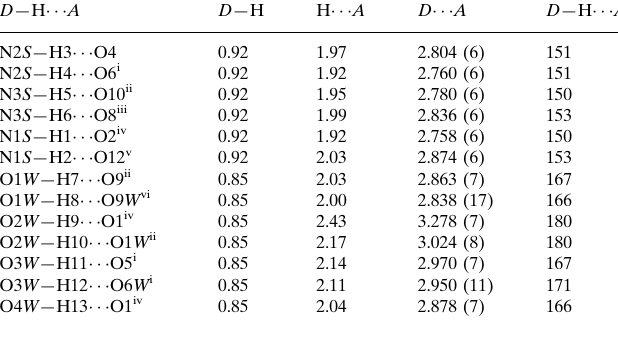
Hydrogen-bond geometry (A˚ , (cid:4)